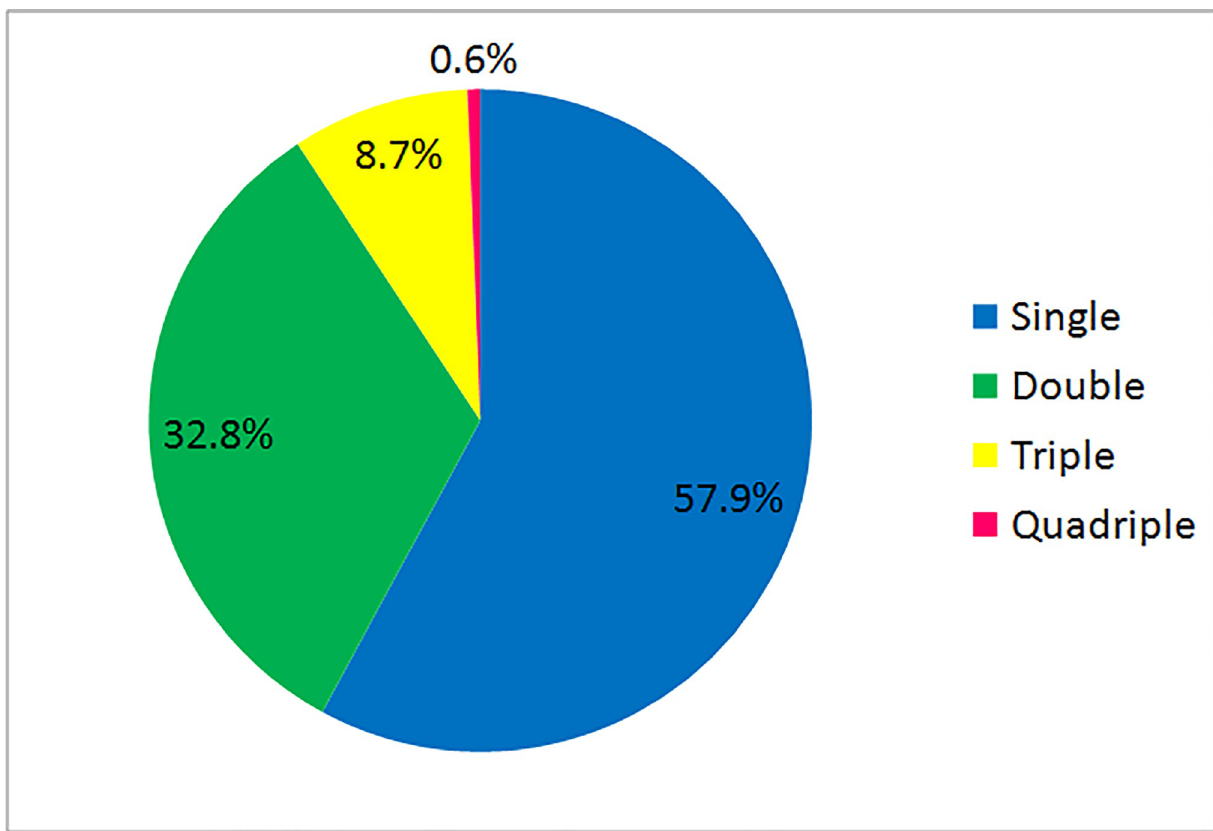
Fig 2. Infection burden of intestinal parasites among populations from three islands of Lake Ziway, Oromia Region, Ethiopia, 2013 (n = 323).